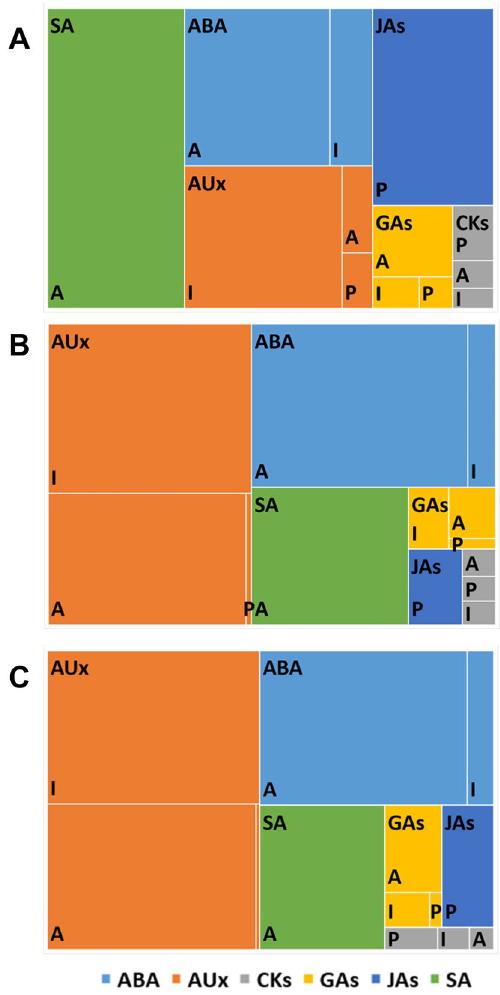
Figure 4. A treemap chart of the hormonal profile of oat cv. ‘Akt’ embryos. Panel ( A ) haploid embryos, Panel ( B ) zygotic embryos, Panel ( C ) zygotic embryos from ovaries treated with 2,4-D. The total area represents the amount of all measured hormones. Rectangles of different colors: AUx auxins (orange), JAs jasmonates (navy blue), ABA abscisic acid (blue), GAs gibberellins (yellow), SA salicylic acid (green), and CKs cytokinins (grey) represent the share of each compound group divided in to active (A), inactivated (I), and precursor (P)